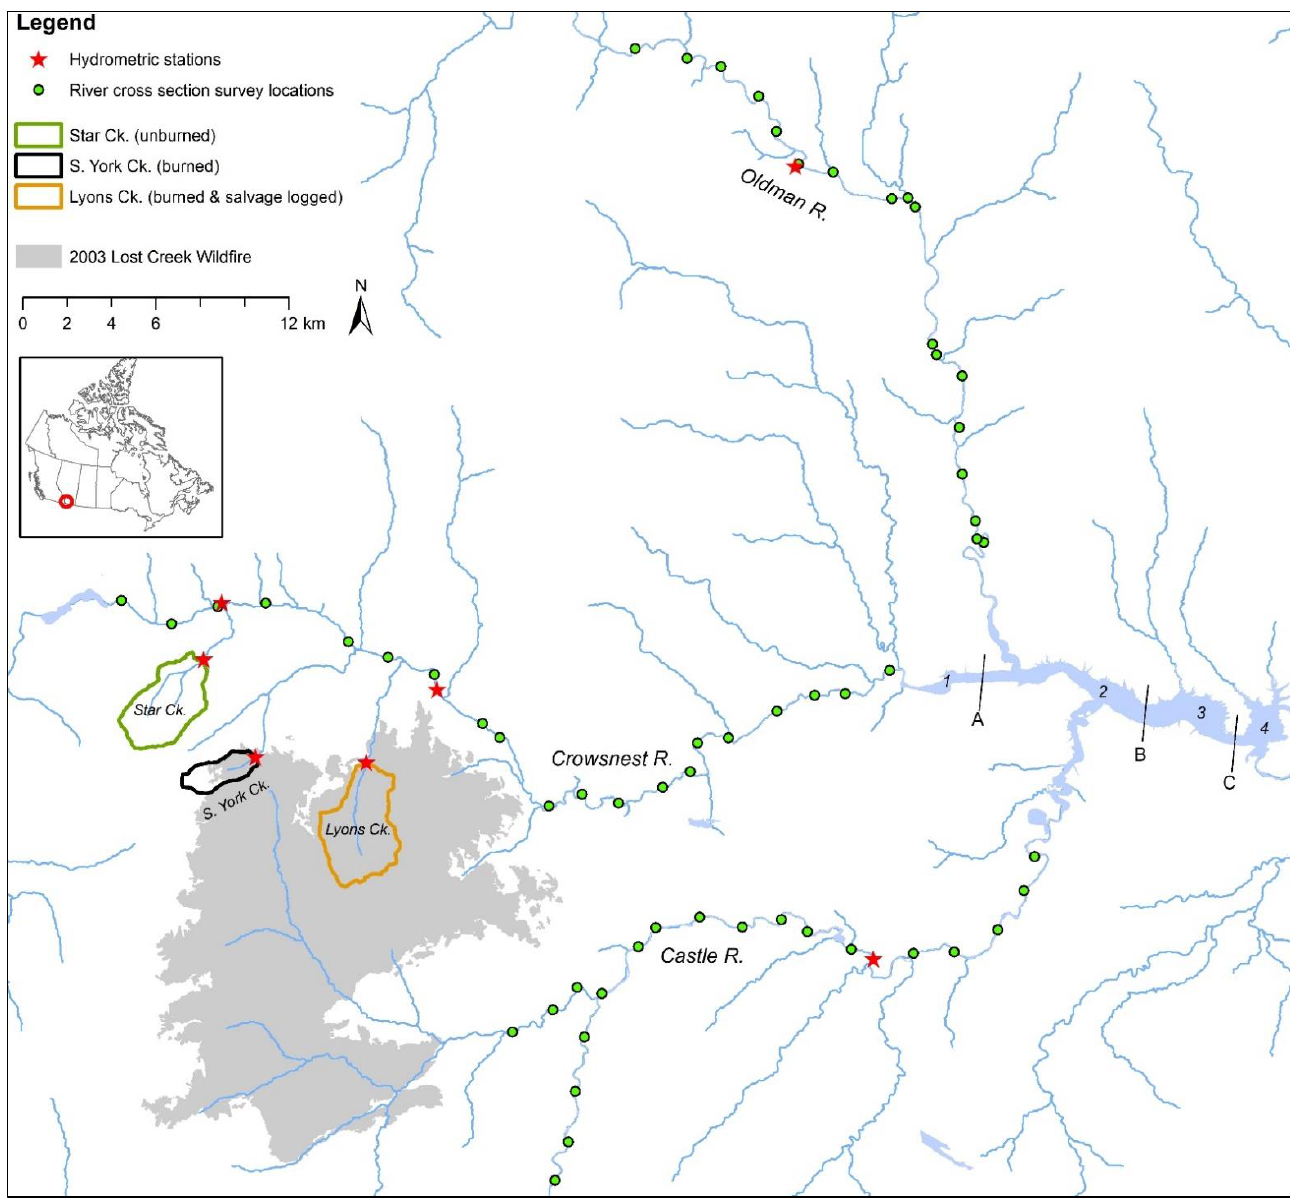
Figure 1. Study area. Upper Oldman River basin including the upper Oldman, Crowsnest and Castle Rivers, locations of cross section surveys, Water Survey of Canada and Southern Rockies Watershed Project hydrometric stations and three gauged unburned, burned, and post-fire salvage logged catchment tributaries to the main stem of the Crowsnest River. Inset shows study region in southwest Alberta, Canada.